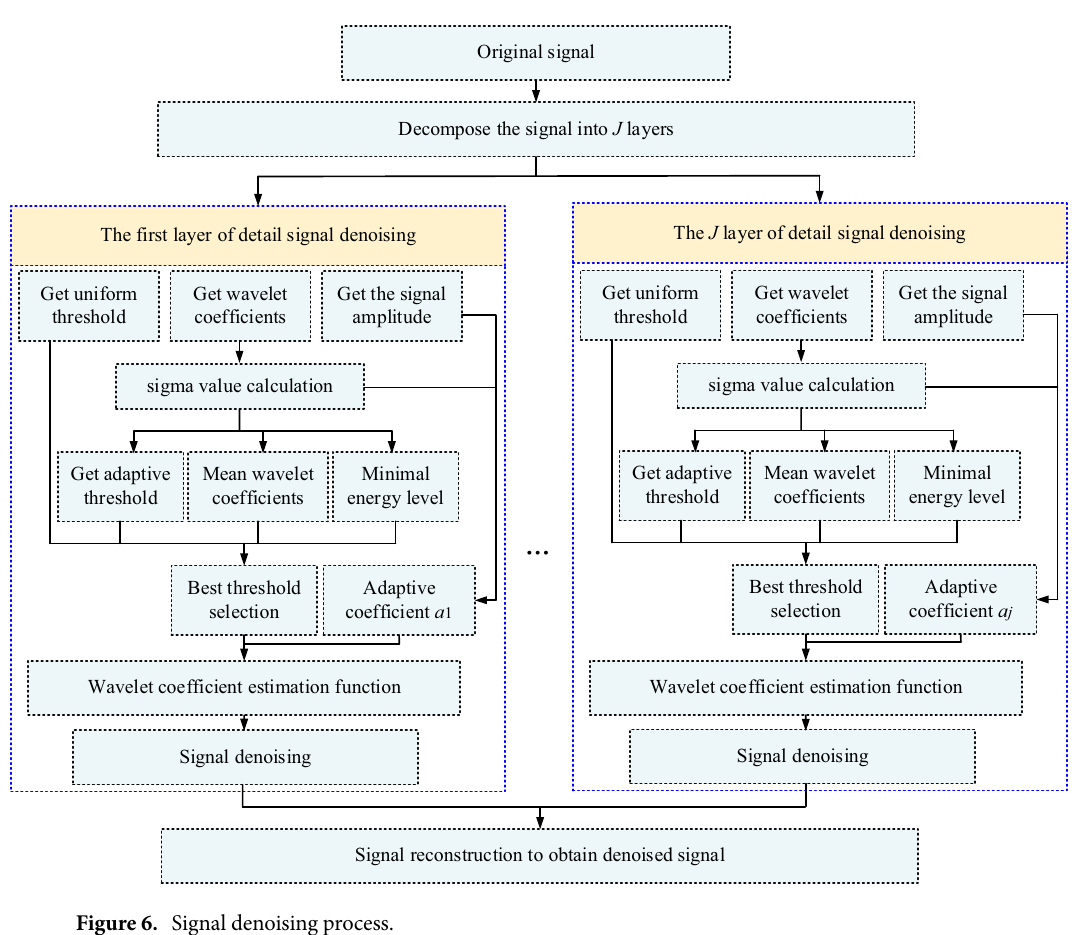
Figure 6. Signal denoising